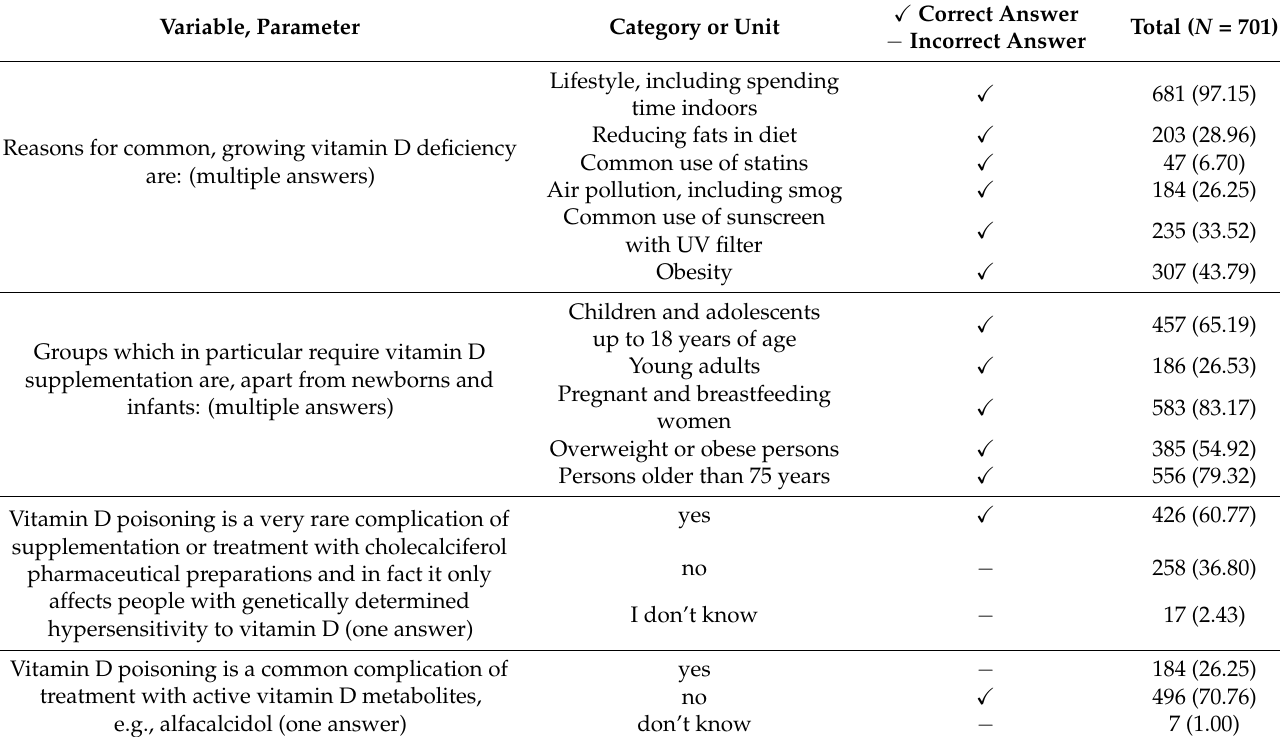
Table 7. Vitamin D knowledge in the study